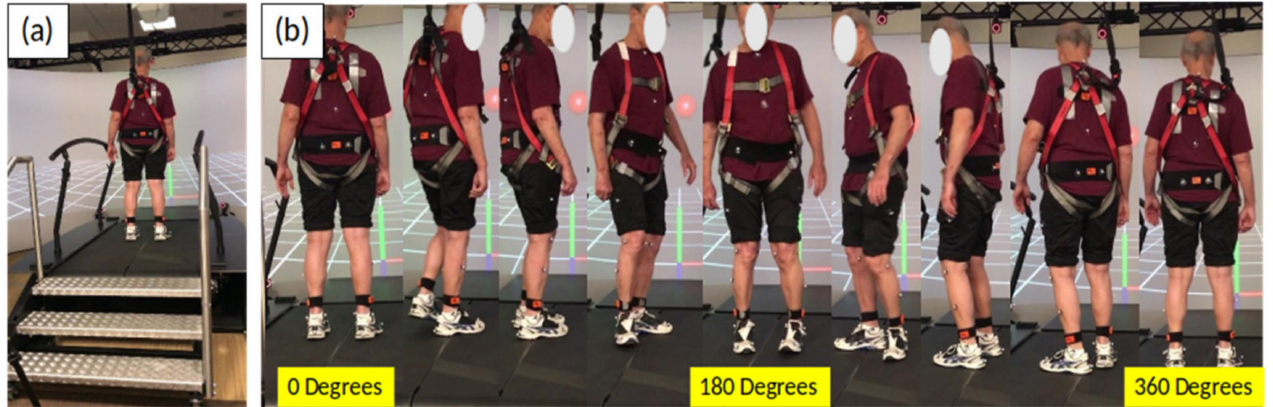
Figure 1. ( a ) Experimental setup where a representative participant is supported by an overhead harness and looking at a virtual target. ( b ) Participant turning 360 ◦